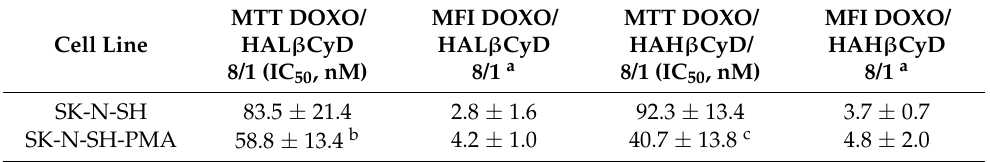
Figure 4. Correlation between IC 50 of DOXO (y = − 0.0323X + 5.5905, r 2 0.670, n = 10, p < 0.004) either administered as parent drug or as CyD polymer complexes and its uptake into SK-N-SH and SK-N-SH-PMA cells. Table 3. Correlation between IC 50 of complexes DOXO/HAL β CyD 8/1 and DOXO/HAH β CyD 8/1 and their DOXO uptake .